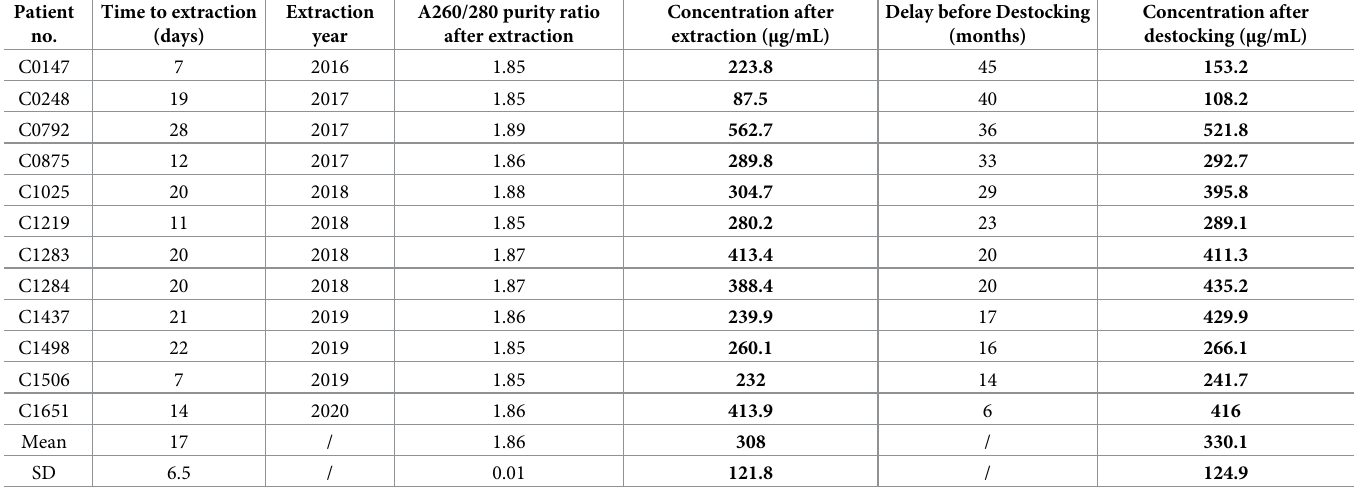
Table 5. Quality metrics of DNA isolated from blood after destocking from the biobank. The concentration and purity of the DNA samples isolated from the patients’ blood were evaluated based on spectrophotometric measurements at 260 nm and 280 nm. Patient